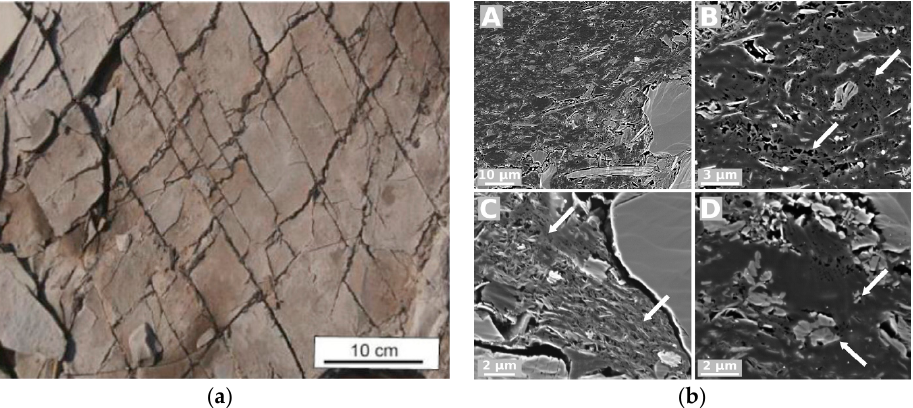
Figure 2. Shale samples. ( a ) Outcrop of natural fractures in Woodford Shale, Oklahoma, USA [3]; ( b ) High-resolution images of Montery shale, California, USA [4]. A, B, C/D are the scan images under different resolutions for the same shale core sample. A, B, and C are for the same core sample, under different resolutions, 10 μ m, 3 μ m and 2 μ m respectively. D is for another core sample under 2 μ m resolution. Arrows in B and C mark pores less than 80 nm. Arrows in D mark carbonate micrite. To simulate gas production in shale, complex gas transport mechanisms and the presence of natural and hydraulic fractures need to be considered, which makes the simulation of shale gas